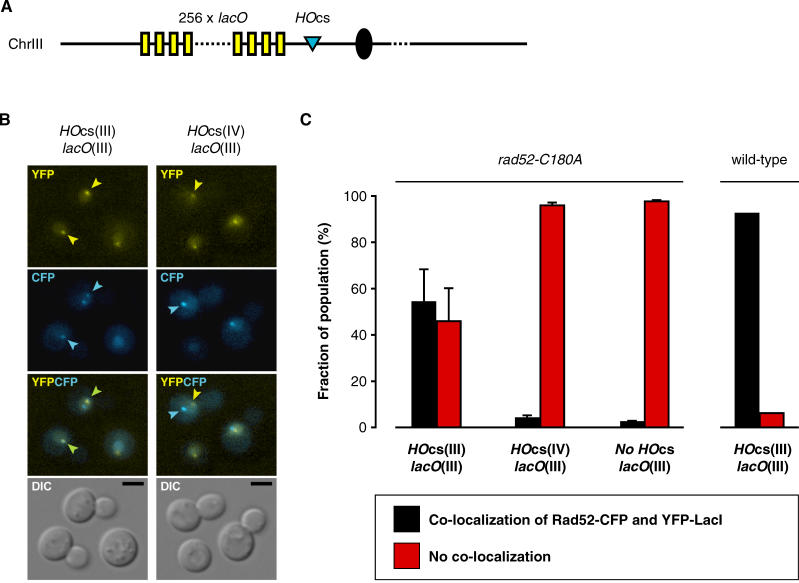
Rad52-C180A-CFP Is Recruited to a Specific DNA Double-Strand Break(A) Assay in Chromosome III for visualizing an HO-endonuclease inducible DSB. Yellow boxes: lacO sites. Cyan triangle: HO cut-site (HOcs). Solid circle: centromere.(B) Localization of a Rad52–CFP focus to an HO-endonuclease-induced DSB. The panels show YFP, CFP, CFP/YFP-merged, and DIC images of representative cells of a strain expressing Rad52-C180A-CFP in a strain with a lacO tandem array next to an HOcs on Chromosome III (left, strain W4021-20A) and in a strain with an HOcs on Chromosome III and a lacO tandem array on Chromosome IV (right, strain W4341-16A). The lacO tandem array is visualized by LacI-YFP as a yellow focus. The marked foci (arrowheads) in the left panels are examples of Rad52/LacI co-localization and the arrowheads in the example on the right indicate the absence of co-localization when the lacO elements and the HOcs are on different chromosomes. Scale bar, 3 μm.(C) Quantitative analysis of co-localization between Rad52-CFP and YFP-LacI foci. Chromosomal locations of the HOcs and the lacO tandem array are given below the histogram columns. As a control, strain W4341-6D with no HOcs was analyzed. The wild-type dataset shown for comparison is from [39].